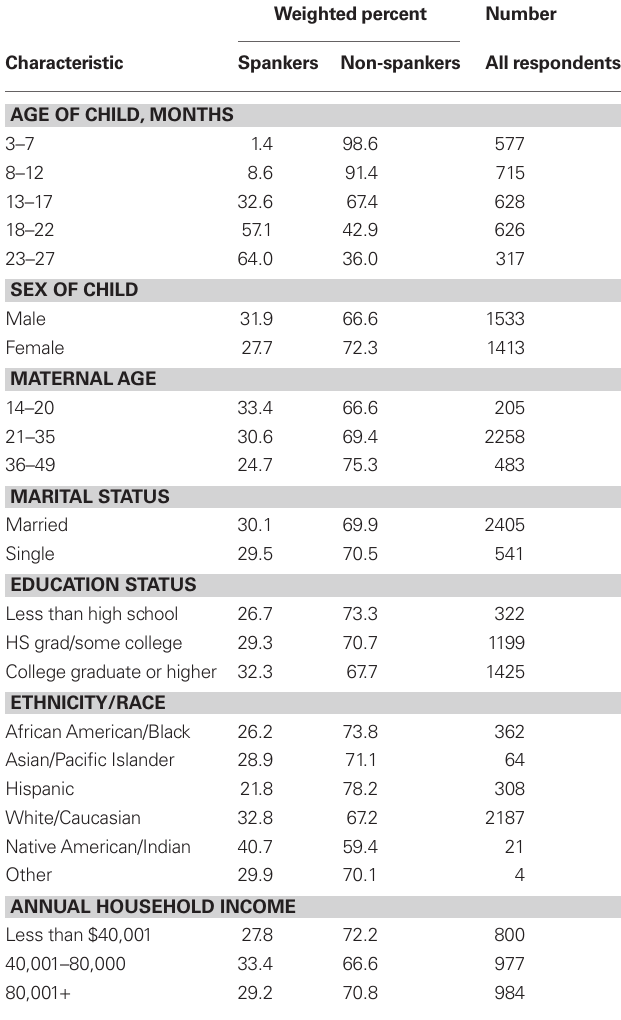
Table 2 | Weighted comparison of spankers and non-spankers ( N =